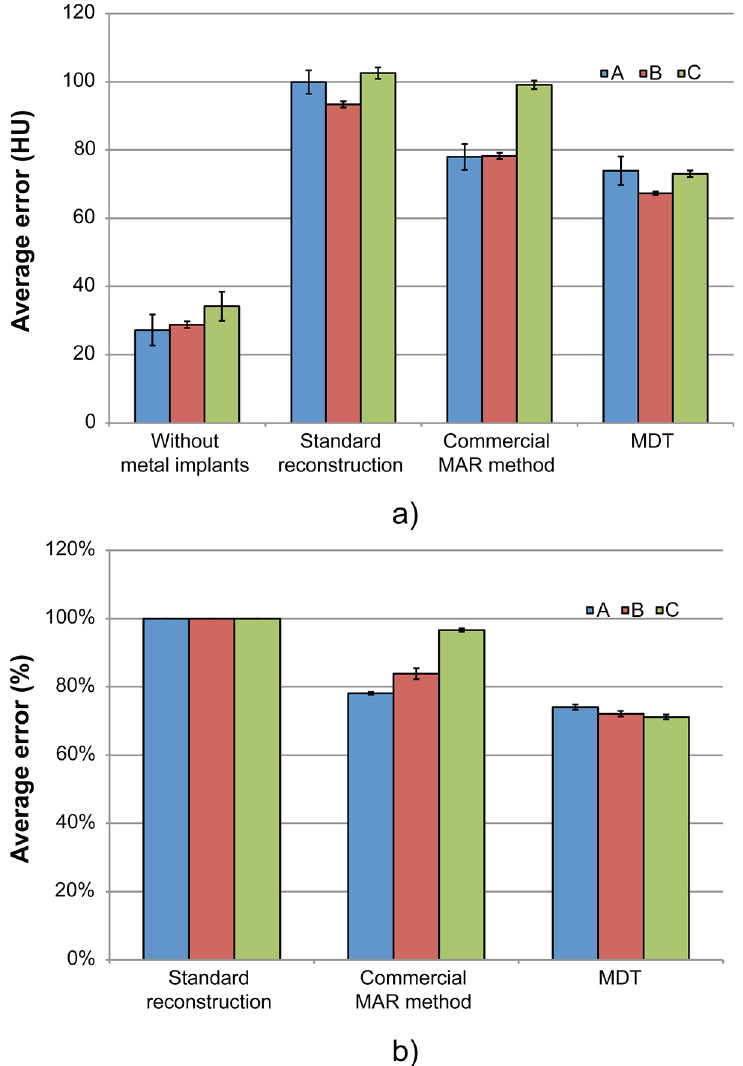
Fig 4. The average absolute error (AAE) with and without different metal artifact reduction (MAR) techniques. (a) The AAE between reference scans, for scans without MAR, for scans with the commercial MAR technique and for scans corrected using the MDT software. For S3, MAR2 is displayed. (b) The AAE reduction after the application of both the commercial MAR techniques and the metal deletion